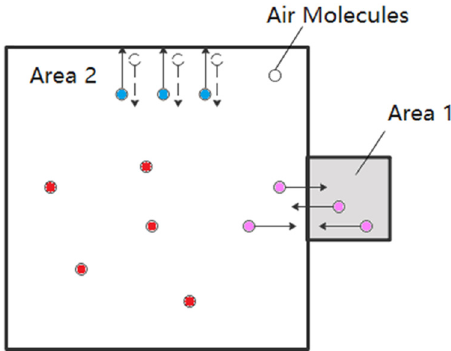
Figure 7: Schematic diagram of air molecular collision in the chan - nels. This diagram demonstrates the possible movements of air molecules from area 2 to area 1, one is to stop at area 2, the other is to pass through a small pipe to area 1, and some will collide with the sidewalls of area